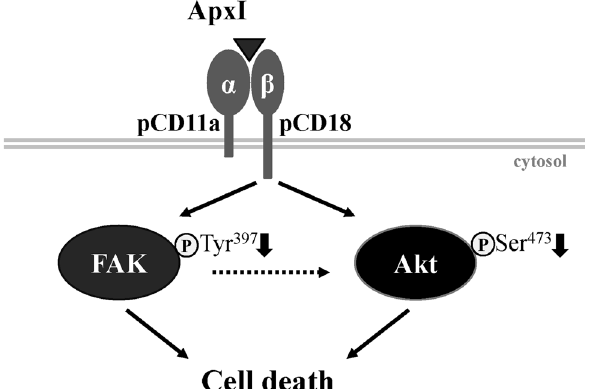
Figure 8. A schematic model illustrates the interaction of ApxI with LFA-1 and the signaling events affected by ApxI. Porcine LFA-1 (pCD11a/pCD18) serves as a potential receptor for ApxI. The CD18 subunit mediates the decreases in the levels of p-FAK Tyr397 and p-Akt Sern in response to ApxI. Attenuation of FAK and Akt activity contributes to ApxI-induced cell death. Whether ApxI attenuates Akt activity in a FAK-dependent manner (dotted line) must be further investigated. The diagram was drawn using Microsoft PowerPoint 2013 (https :// www.micro